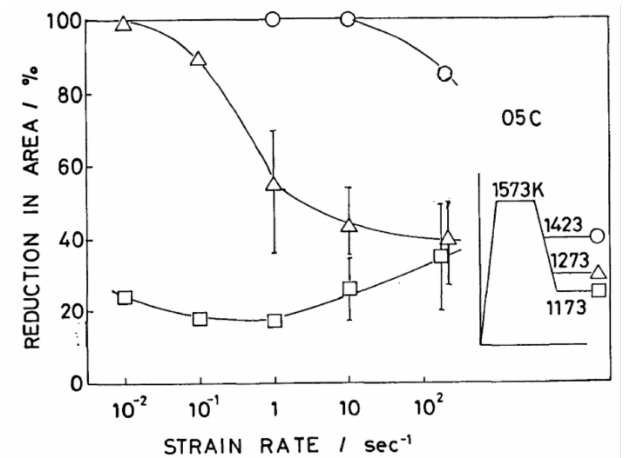
Figure 8. Strain rate dependence of hot ductility at different test temperatures for a C-Mn steel with S as impurity. Reprinted from ref.